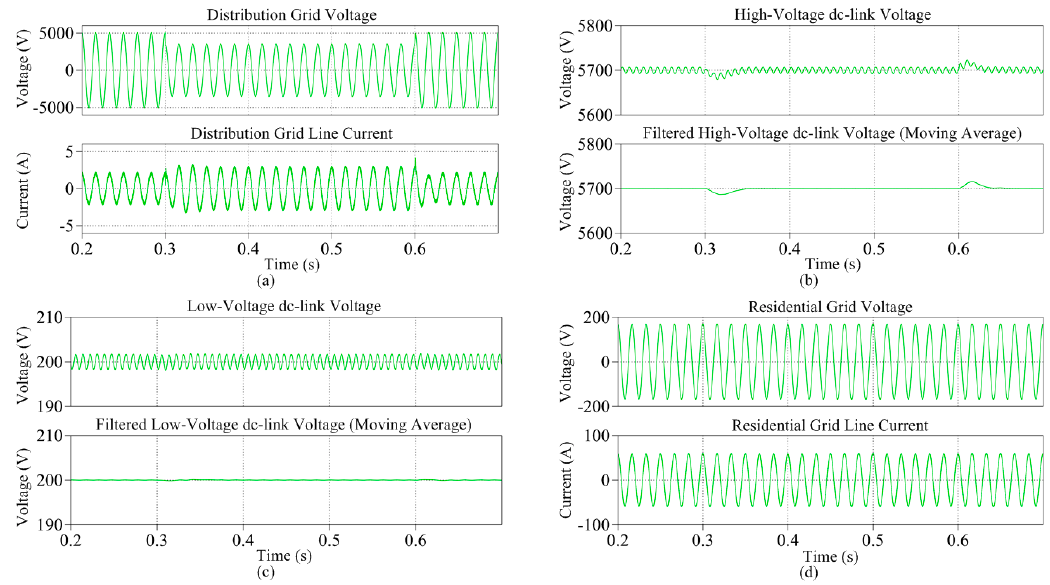
Figure 11. The major voltage and current waveforms in the various parts of the SST system under the voltage-sag scenario ( i d * = 59 from 0 to 0.7 s, for the residential grid i q * = 39.3 (lagging) from 0.3 s, and for the distribution grid i q * = − 1.3 (leading) from 0.5 s); ( a ) Distribution grid voltage and current, ( b ) high-voltage-side dc-link voltage, ( c ) low-voltage-side dc-link voltage, ( d ) residential grid voltage and current.